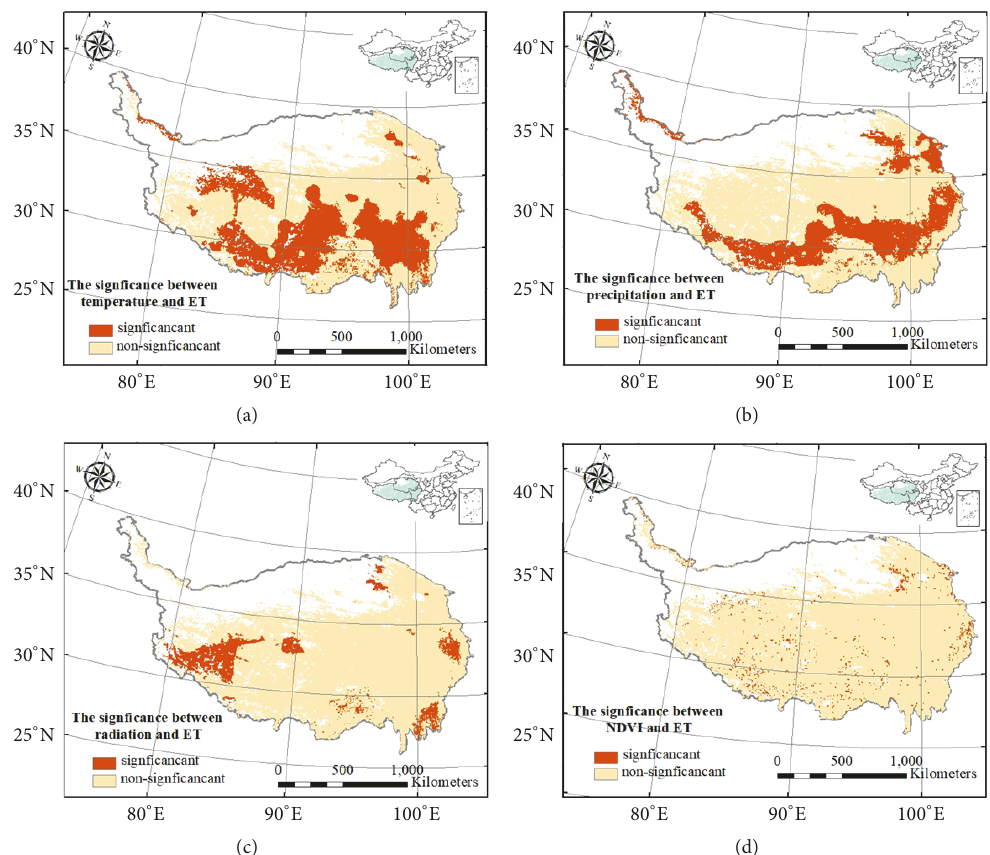
Figure 5: The significant changes of ET with four environmental factors across the Tibetan Plateau. Graphs (a), (b), (c), and (d) represent the variations with temperature, precipitation, radiation, and NDVI,